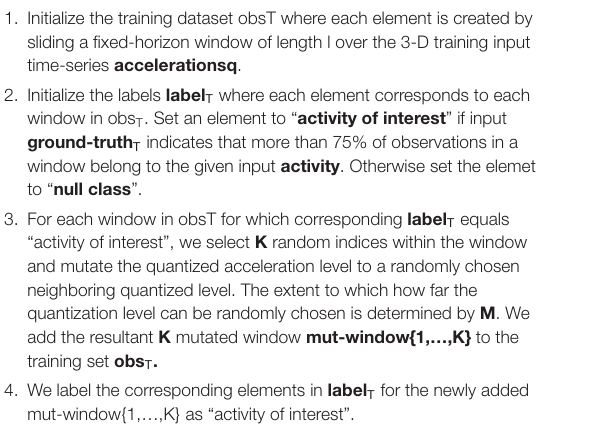
Algorithm 1: Algorithm of the genetic mutation based